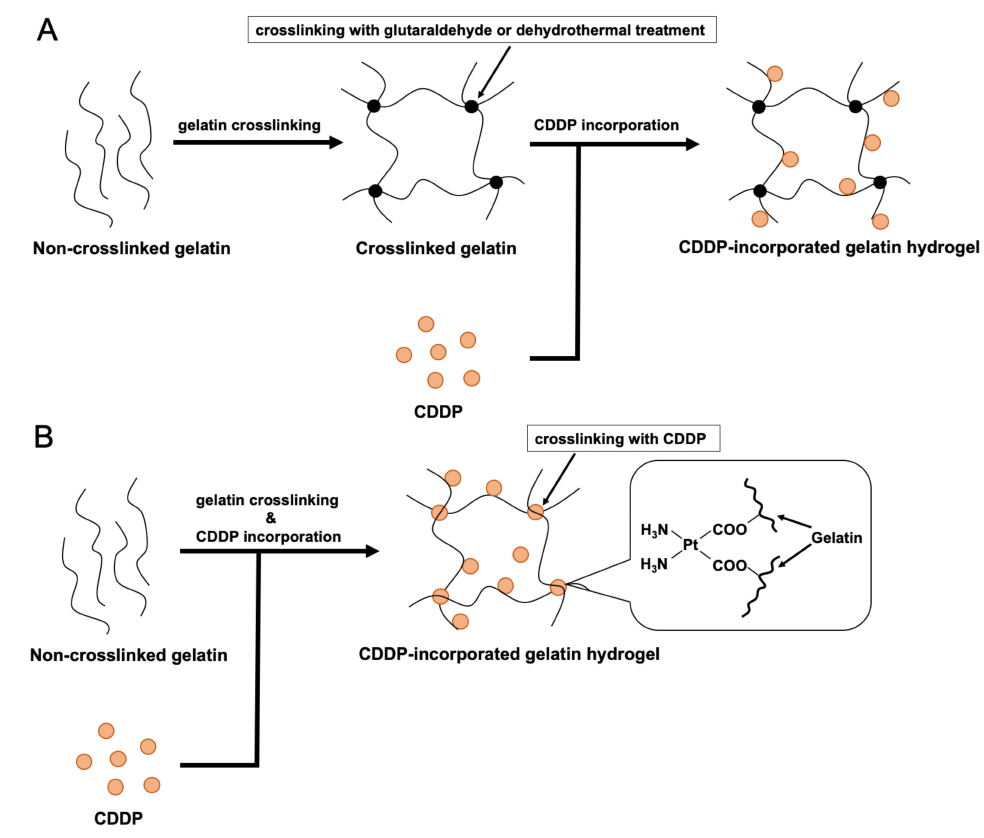
Figure 1. Preparation method for gelatin hydrogels incorporating CDDP for sustained CDDP